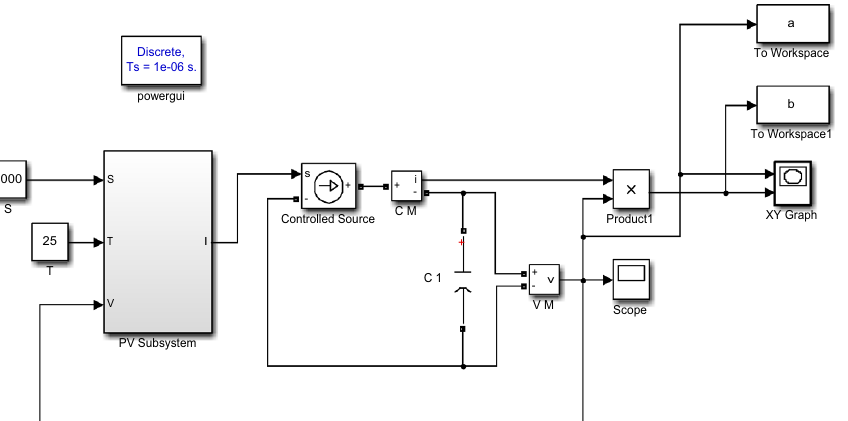
Figure 8. P–U characteristics simulation model.